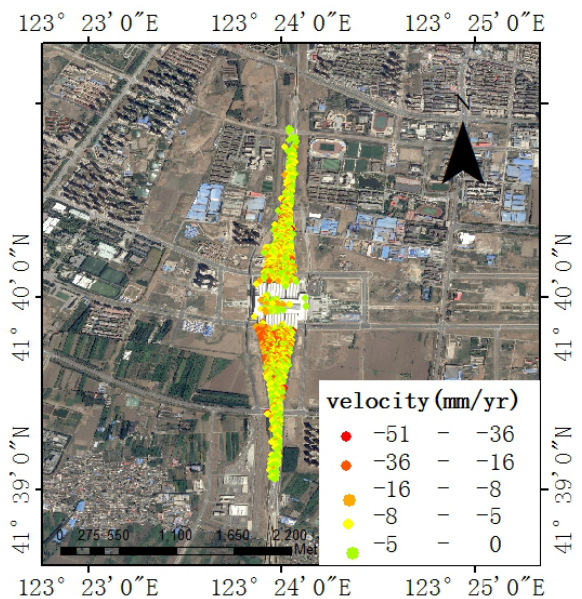
Figure.2(b) Overall deformation pattern from the eastern stack